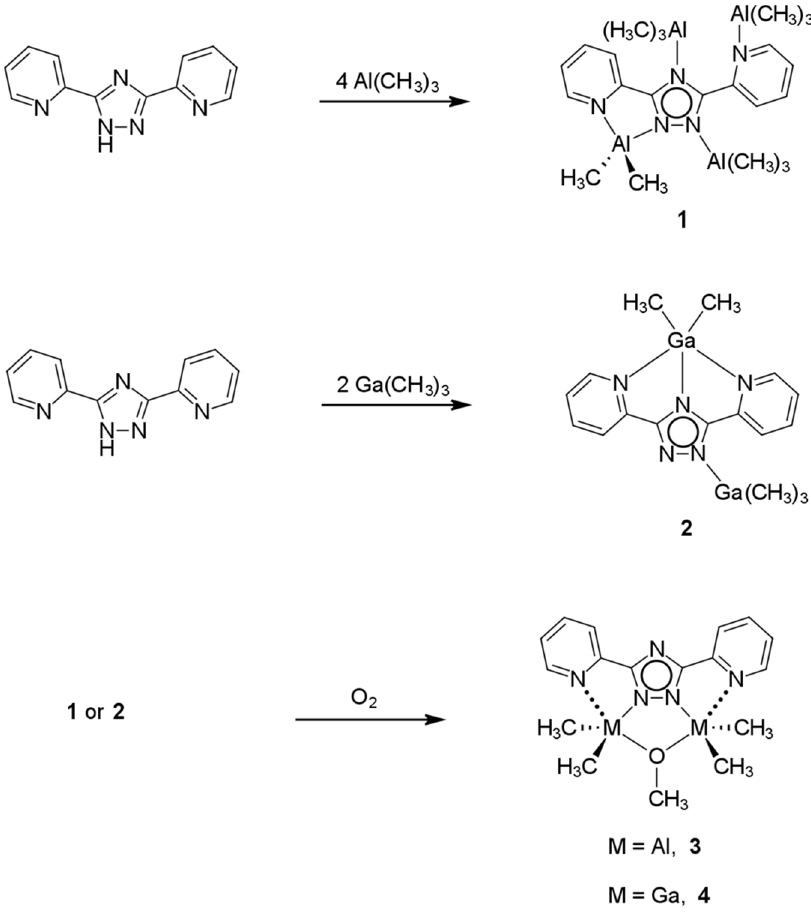
Figure 1. Synthesis scheme of 1–4.